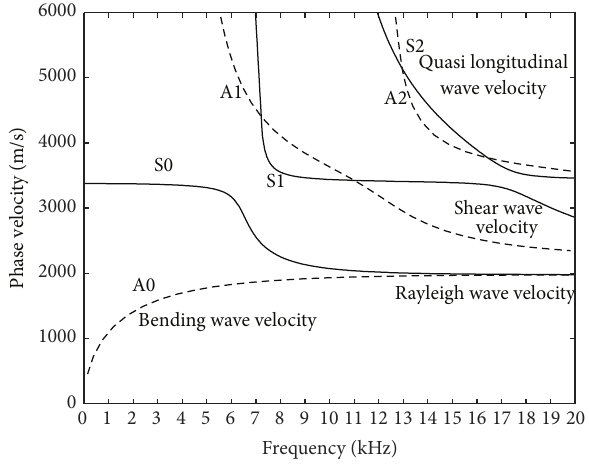
Figure 6: Phase velocity dispersion curves determined by MASW (based on the FE simulation of a concrete slab with a thickness of 0.3 m). A density of 2250 kg/m 3 , an elasticity of 23 GPa, and a fixed Poisson’s ratio of 0.167 are assumed for the concrete